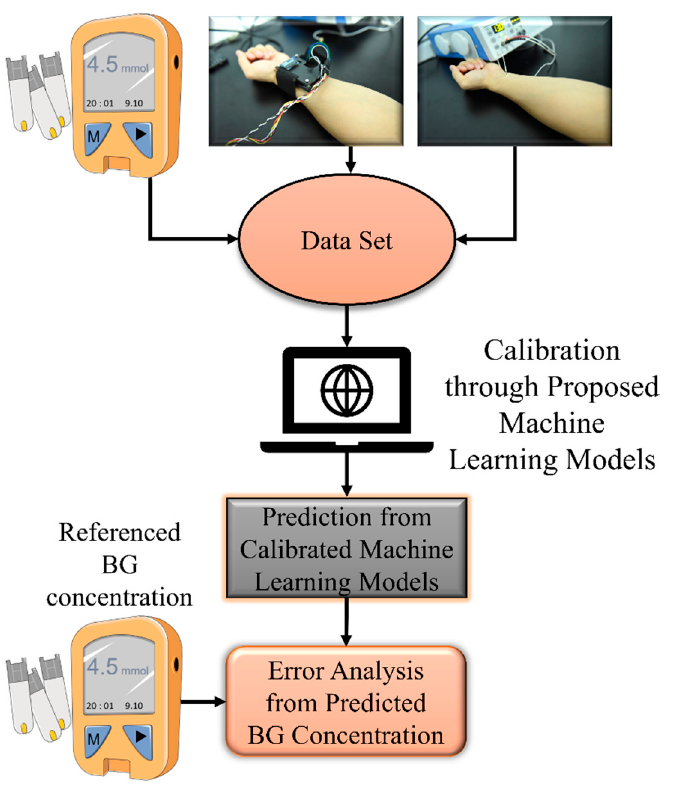
Figure 2. Operation process of the proposed device.